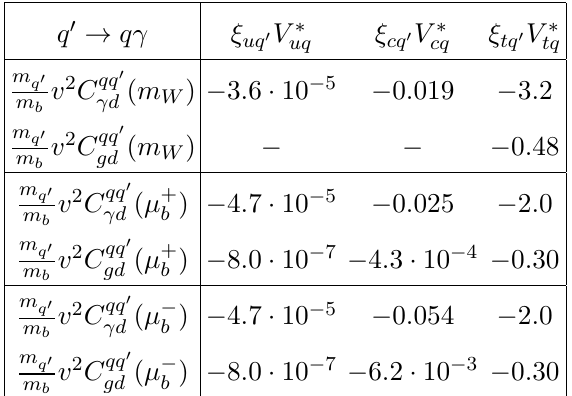
Table 6 . Contributions of the right-handed W -current to the q 0 ! q(cid:13) dipole operators at (cid:22) = m W and (cid:22) = (cid:22) (cid:6) = 2 GeV. Here (cid:22) (cid:0) and (cid:22) + di(cid:11)erentiate between cases in which the charm quark has b b b been integrated out at (cid:22) = (cid:22) b , or is still present within the EFT, respectively. A \ (cid:0) " denotes the contribution is negligible for our